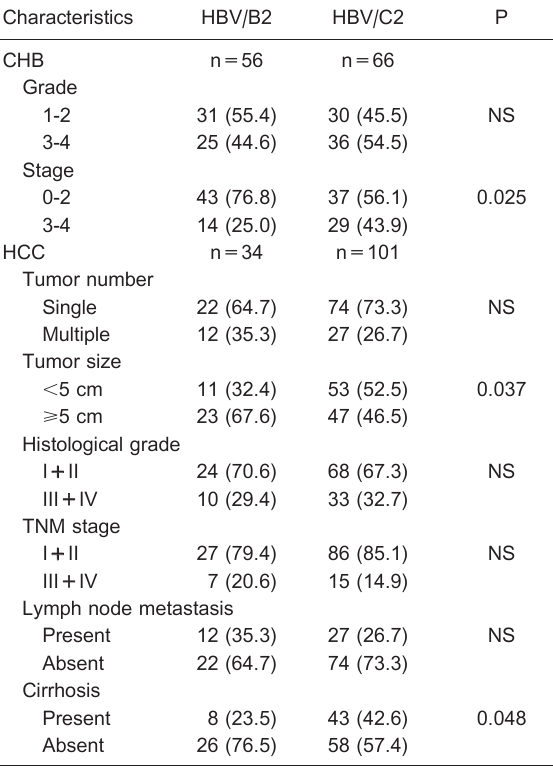
Table 2. Serological and virologic markers for chronically infected patients with HBV subgenotype B2/C2. Markers